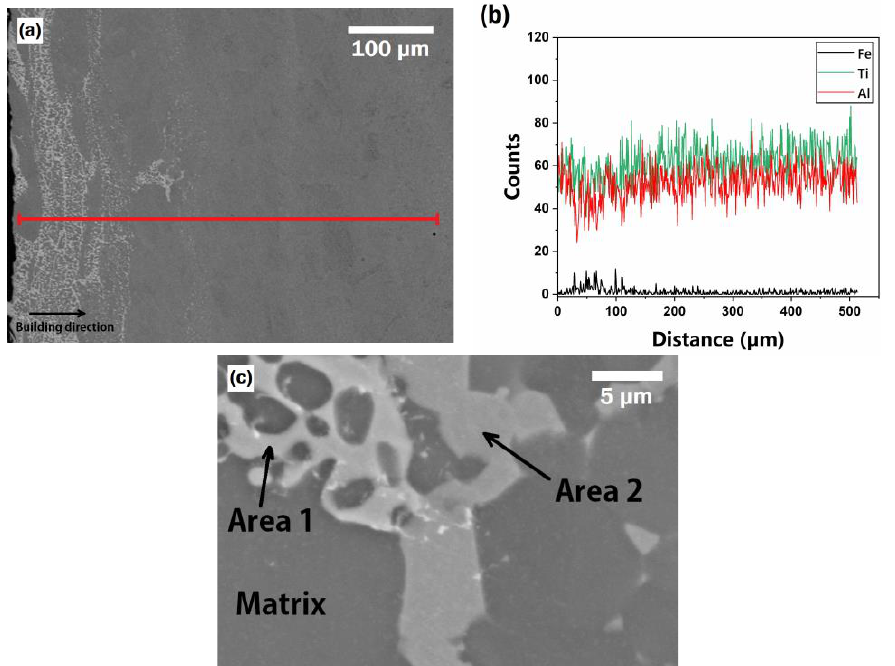
Figure 4. ( a ) SEM micrograph of the as-built condition, ( b ) distribution of different elements along the building direction (from left to right), and ( c ) the region with higher magnification. Table 2. Chemical composition (in wt.%) of different regions of Figure 4c.